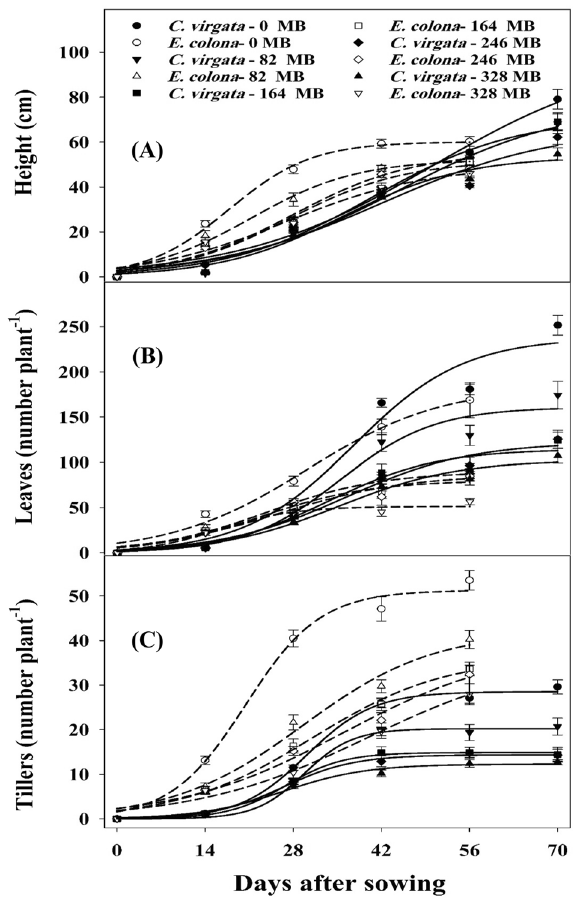
Figure 1. ( A ) Plant height (cm), ( B ) tiller number per plant, and ( C ) leaf number per plant of C. virgata and E. colona when grown alone (0 MB) or in competition with 82, 164, 246 and 328 mungbean (MB) plants. The lines represent a three-parameter sigmoid model (y = a/{1 + exp[− (X − T50)/b]}) fit to plant height, leaf number per plant, and tiller number per plant. The capped bars represent the standard error of the mean. Parameter estimates of the model are given in Table